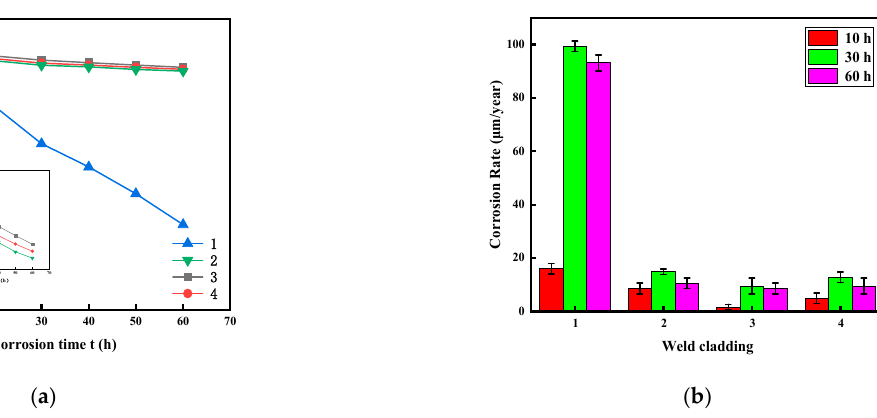
Figure 4. Molten ‐ salt corrosion curve of nitrogen ‐ containing low ‐ nickel weld claddings and Inconel Figure 4. Molten-salt corrosion curve of nitrogen-containing low-nickel weld claddings and Inconel 625 weld cladding. ( a ) Corrosion weight loss curve. ( b ) Corrosion rate diagram. 625 weld cladding. ( a ) Corrosion weight loss curve. ( b ) Corrosion rate